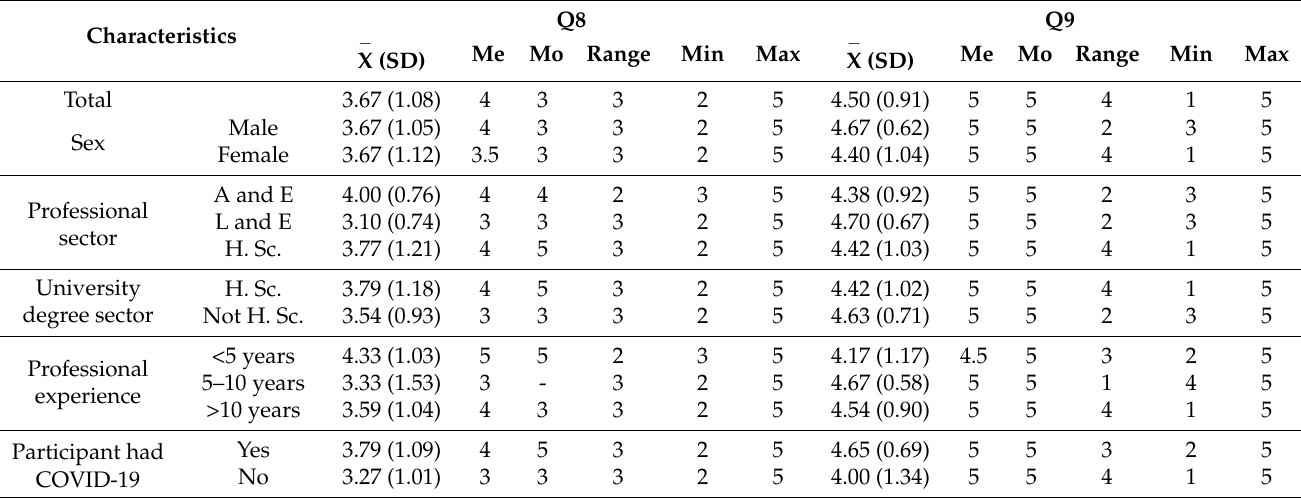
Table 8. Centrality and dispersion of the Likert type questions 8 and 9.